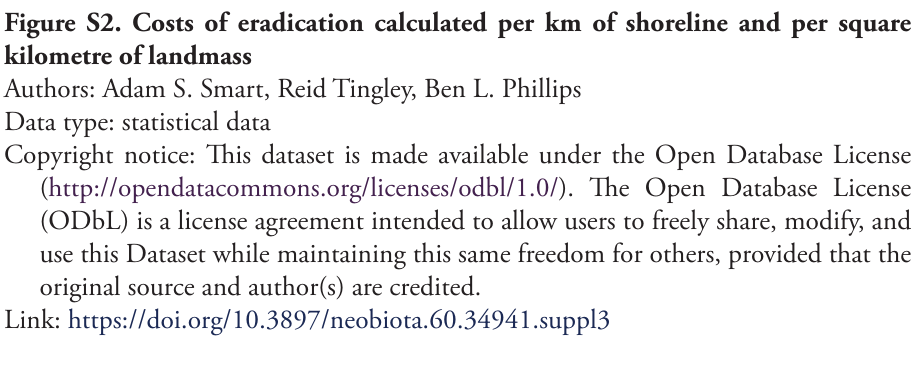
Figure S2. Costs of eradication calculated per km of shoreline and per square kilometre of